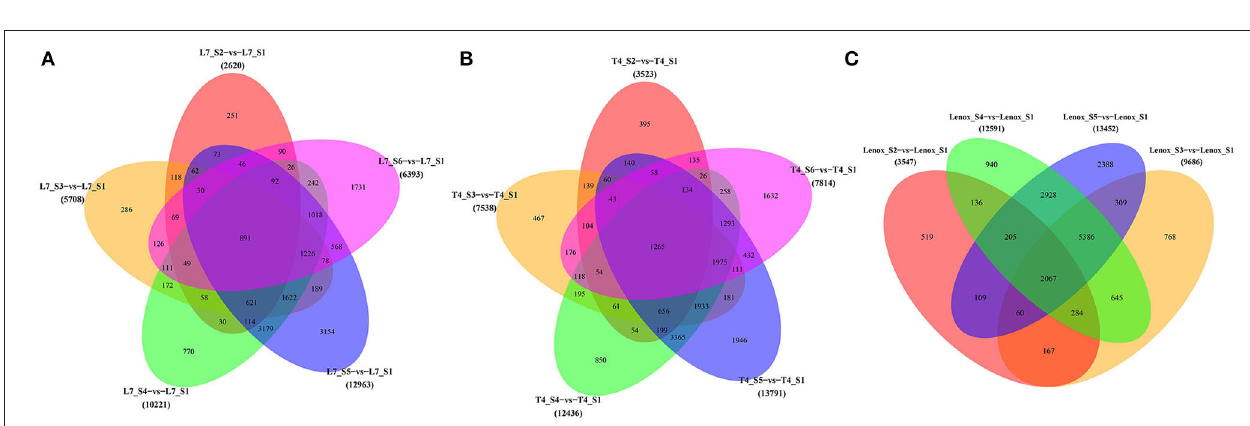
FIGURE 3 | Venn diagrams of differently expressed genes on different stages of (A) Longyou-7 (L7), (B) Tianyou-4 (T4), and (C)